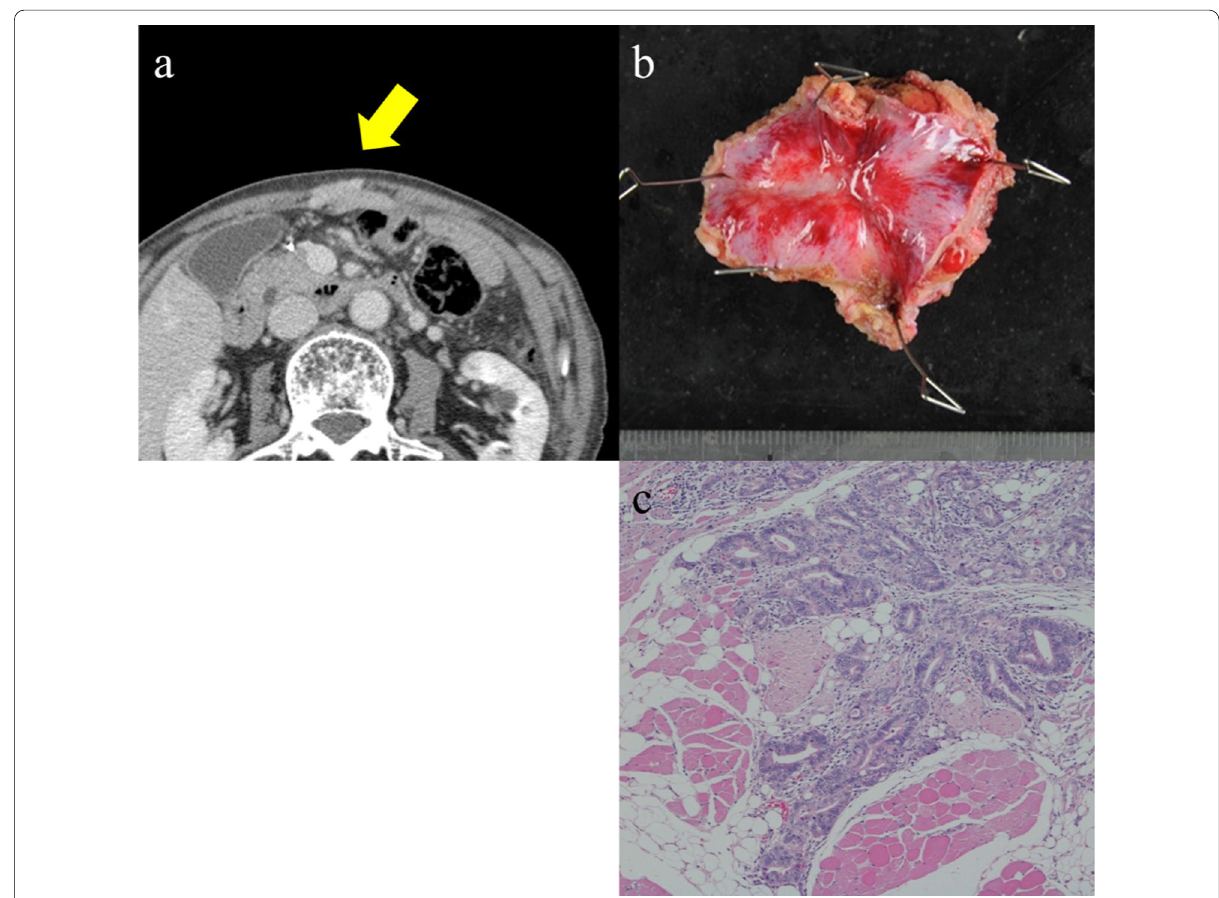
Fig. 3 Computed tomography (CT) scan and pathological findings of the first recurrence. a CT scan shows an enhanced mass in the median line of abdominal wall. b Macroscopic findings show a white nodular lesion in the peritoneum. c Pathological examination reveals an adenocarcinoma consistent with metastatic tumor from gastric